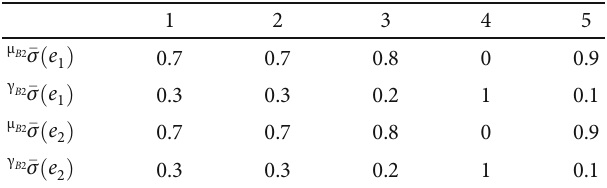
Table 15: Lower approximation of B